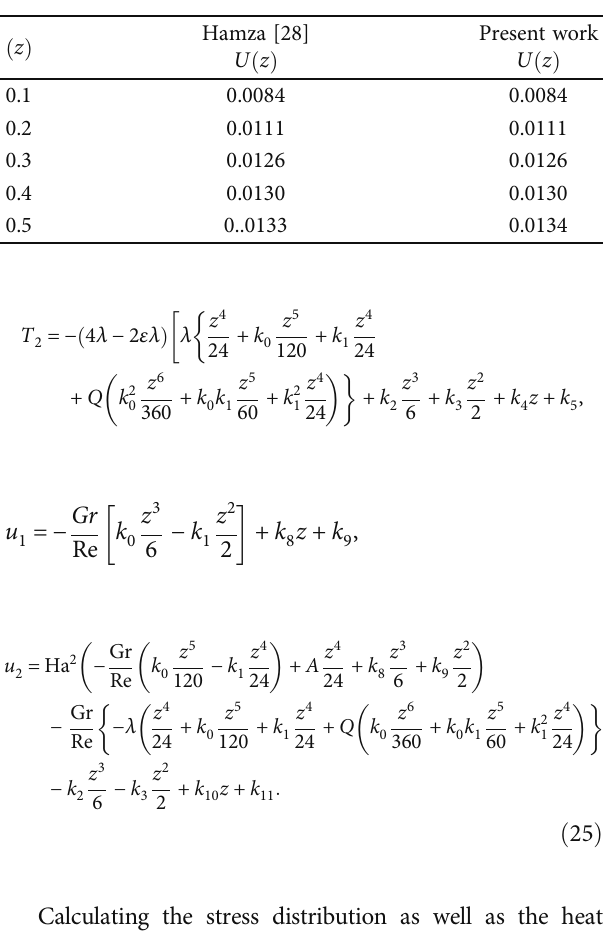
Table 1: Numerical computations comparing Hamza ’ s [29] work with the current work. γ = 0 : 1 , λ = 0 : 1 , Gre = 1 , Hp = 0 : 1 , Ha = 0 , and A = 0